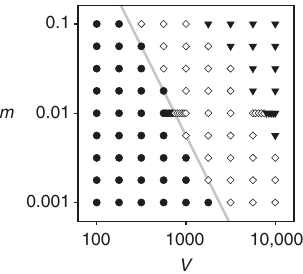
Fig. 3 Phase diagram with respect to cell size ( V ) and mutation rate ( m ). The symbols indicate no symmetry breaking ( fi lled black circle ), symmetry breaking ( open diamond ), and extinction ( downward pointing triangle ). The boundary between (cid:129) and ⋄ approximately follows the scaling relationship mV ∝ 1/ V ( grey line ). The parameters were the same as in Fig. 2